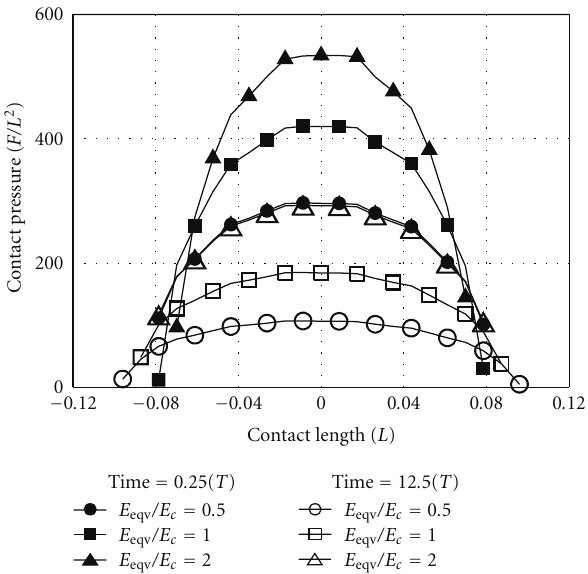
Figure 7: E ff ect of E eqv /E c on relaxation of the central contact pressure.